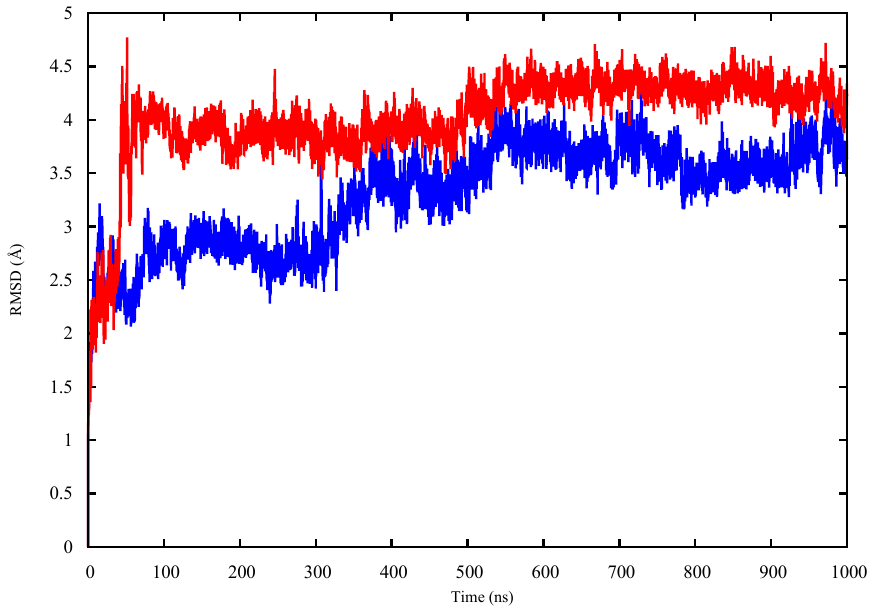
Figure 1. The RMSD plot of the backbone heavy atoms of both wt-p53 (blue) and G245S-mp53 (red) apo monomers over 1 μ s of MD simulations.